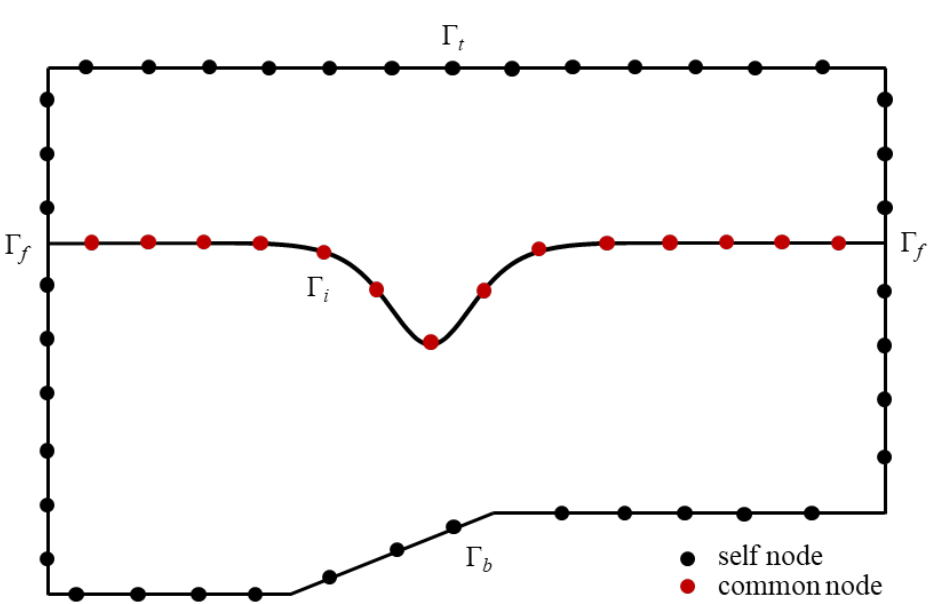
Figure 2. Two types of element nodes of calculation domain boundaries, where black and red dot denote self and common nodes, respectively.